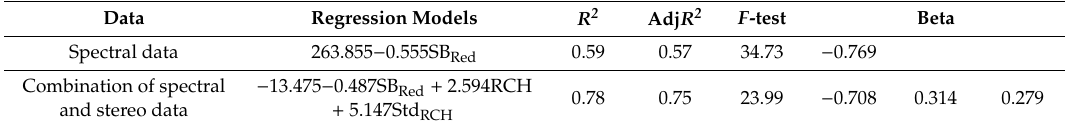
Table 3. Biomass estimation modeling results.